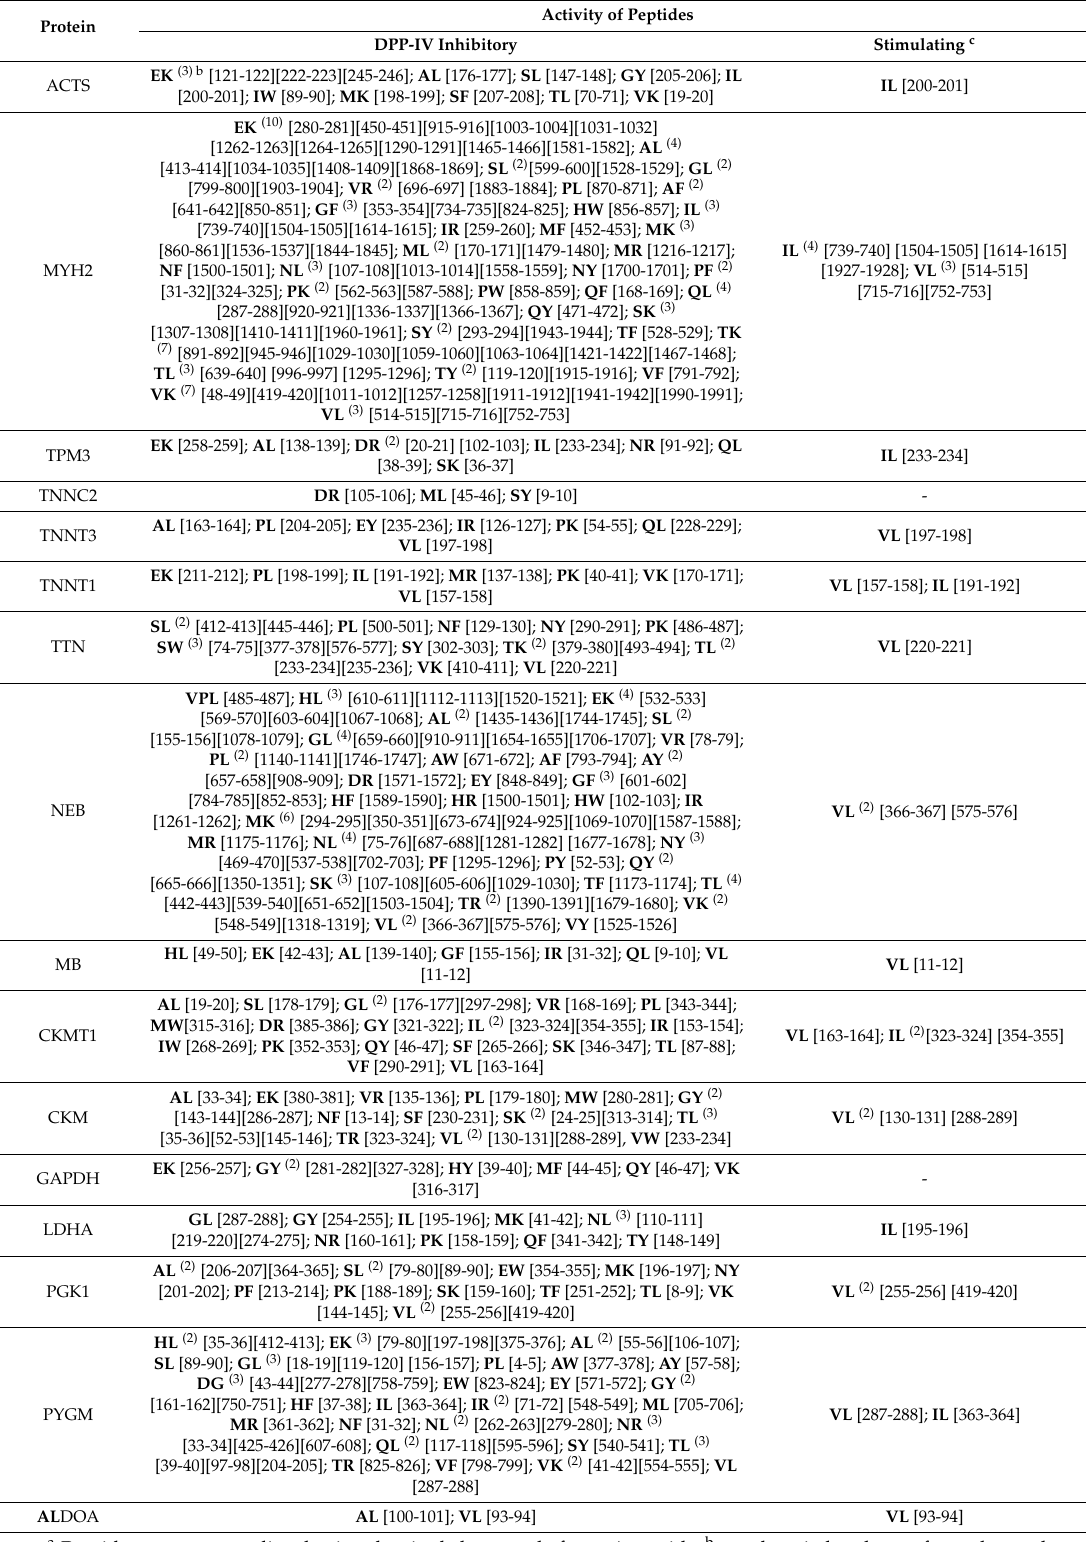
a Peptide sequences are listed using the single letter code for amino acids, b numbers in brackets refer to the total amount of specified active fragments, c